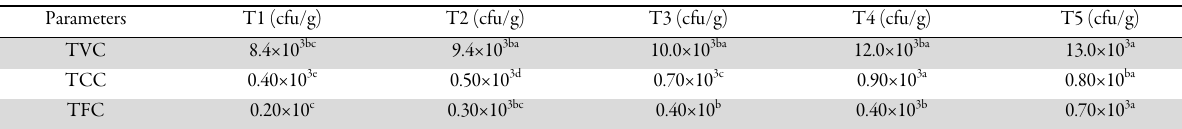
Mean with the same superscript are not significantly different Table 6. Microbial properties of the feed Parameters